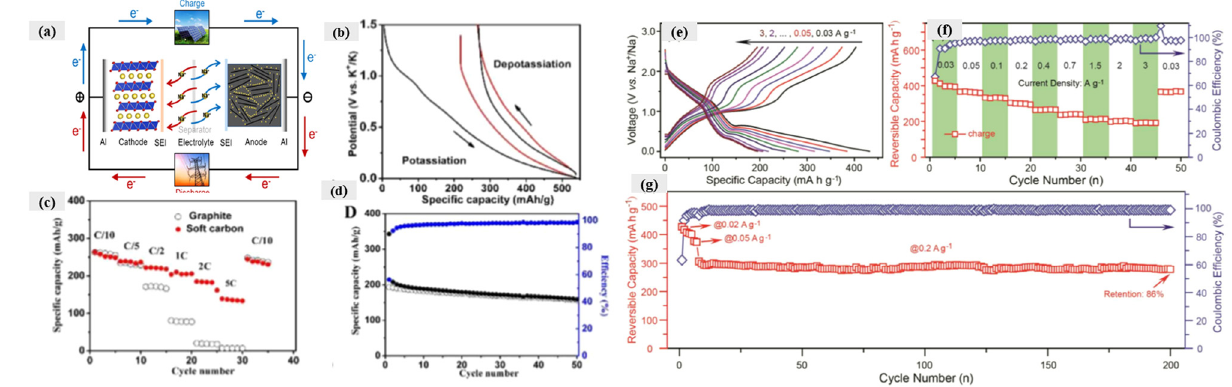
Figure 8: ( a ) Principle of rechargeable Na - ion batteries [ 55 ] . Copyright 2017, Elsevier. ( b ) GPD pro fi les of carbon for the initial two cycles. ( c ) Rate performance of carbon, and ( d ) cycling stability of carbon at 2C [ 57 ] . Copyright 2018, American Chemistry Society. Electrochemical performance of the MnSe@N - CNTs electrode in Na - ion half cells. ( e ) The GCD curves and ( f ) rate capability at di ff erent current density. ( g ) Cycling performance at 0.2 A g − 1 after the fi rst seven cycles at a low current density [ 64 ] . Copyright 2016, Royal Society